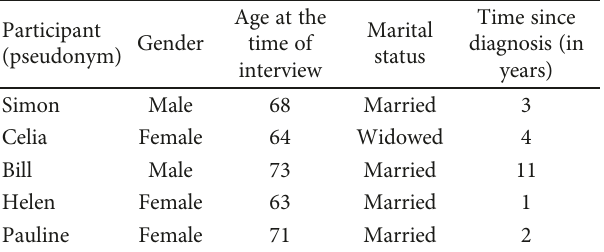
Table 1: Participant